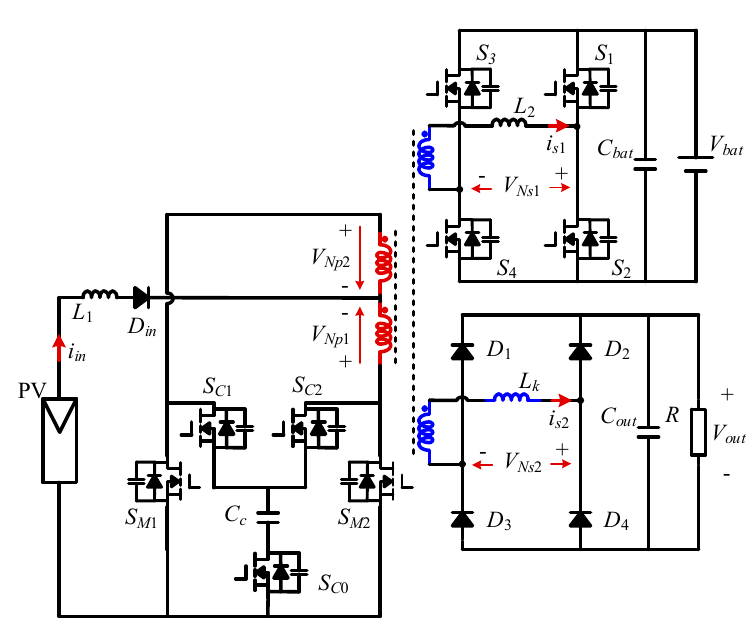
Figure 2. Topology of the basic cell.